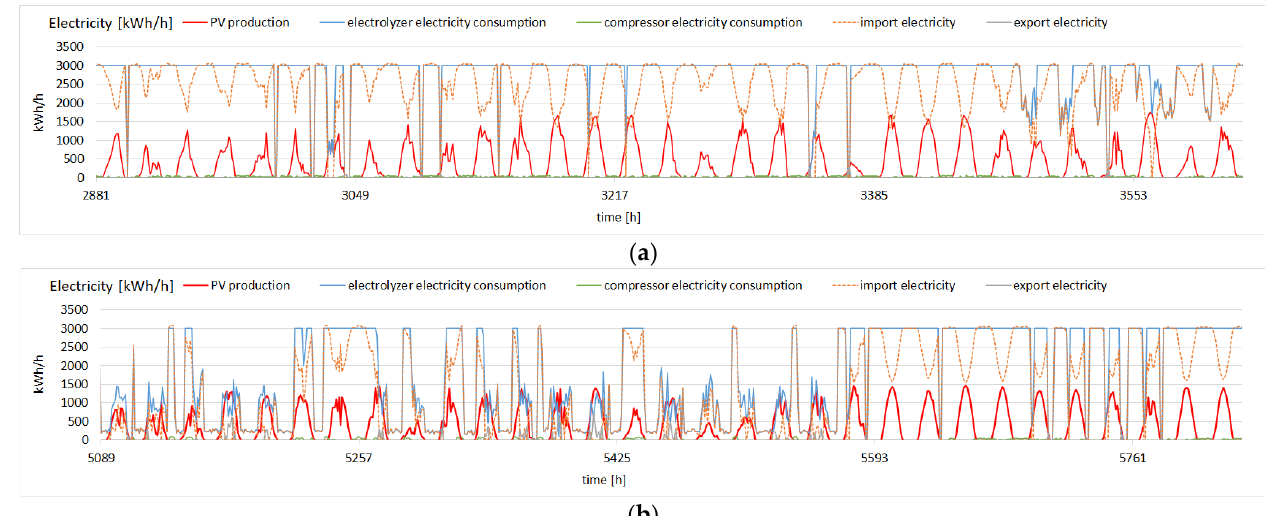
Figure 3. Case hydrogen production and storage (simulation results). ( a ) May; ( b ) August.